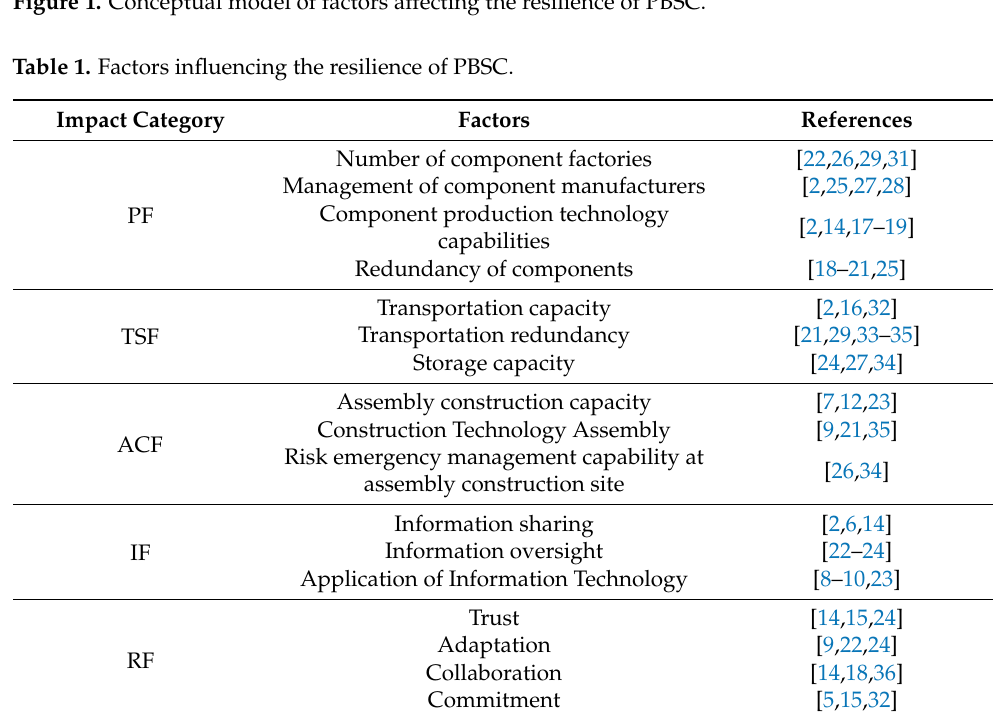
Table 1. Factors influencing the resilience of PBSC.